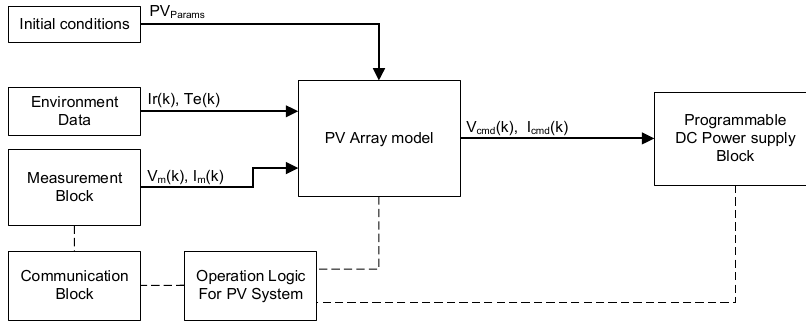
Figure 4. Conventional PV operation algorithm with a Real-time Digital Simulator (RTDS). DC: direct current.